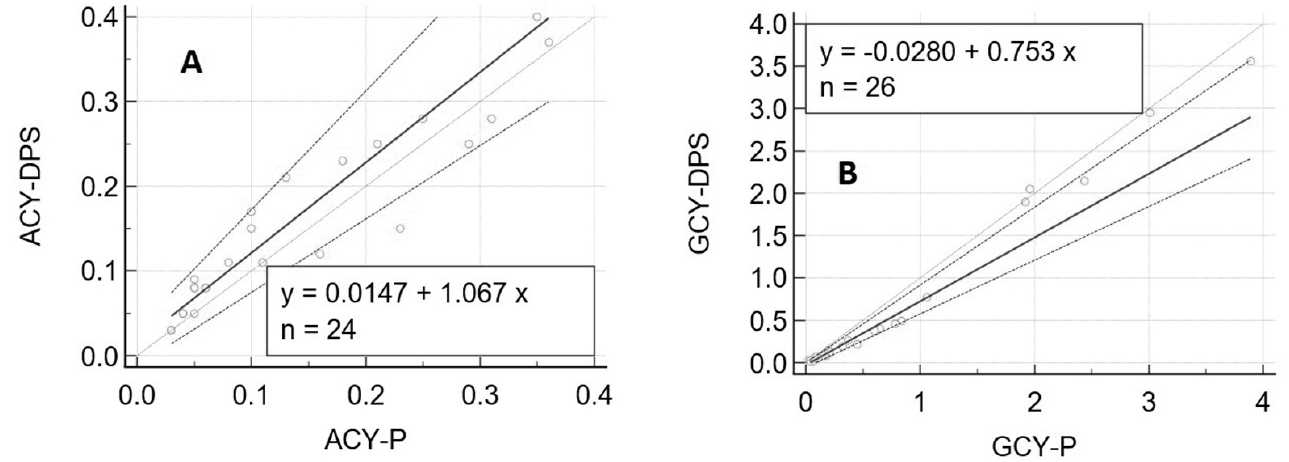
Figure 3. Passing–Bablok correlation plots between aciclovir ( A ) and ganciclovir ( B ) concentrations extracted from plasma. Aciclovir/ganciclovir concentrations (mg/L) measured from plasma are represented on the x -axis and aciclovir/ganciclovir concentrations (mg/L) from DPS on the y -axis. Thick line, regression line; Thin line, identity line; Dashed line, confidence interval for the regression line